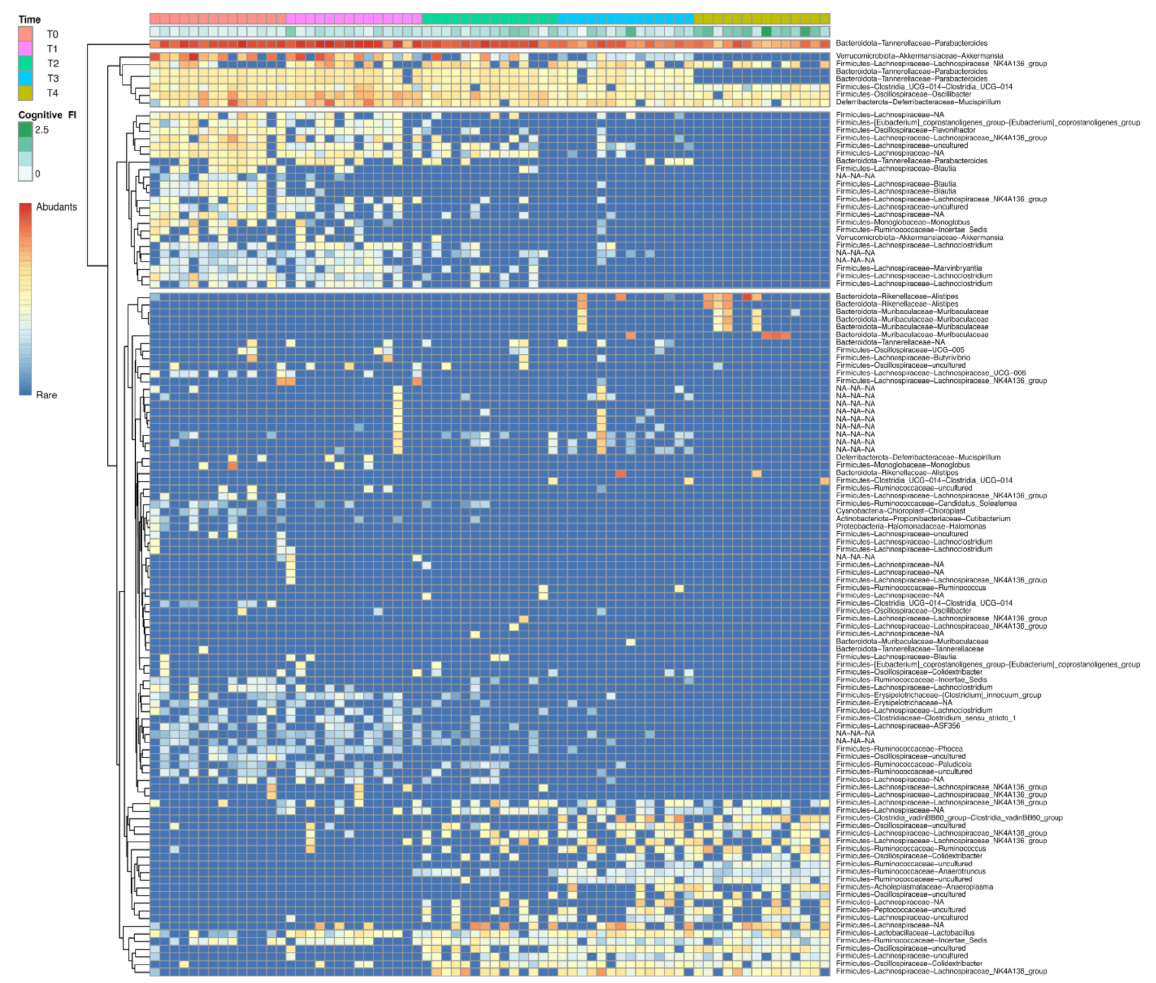
Figure 10. The heat map shows the distribution of the abundances of 218 ASVs whose variation was statistically significant in relation to the variation of the Cognitive FI. The analysis was performed using Deseq2 R package and the heat map was generated using phetamap R package. The variations in terms of abundance are indicated using the coloring scale in the legend. A green-white color scale is used to indicate the variation of Cognitive